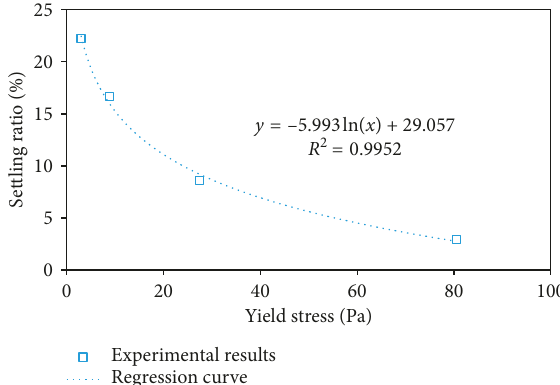
Figure 9: Settling ratio versus yield stress of experimental and regression